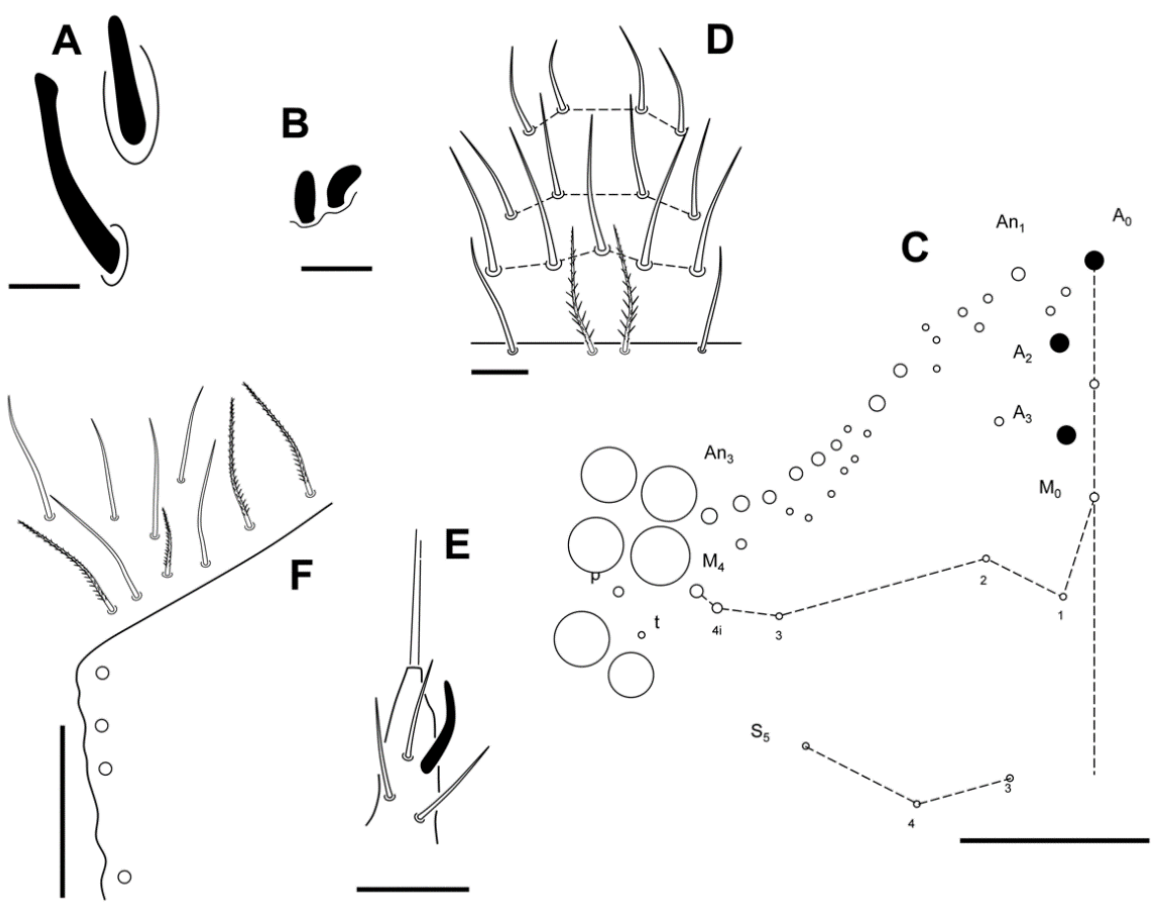
Figure 8. Pseudosinella impariciliata Baquero and Jordana sp. nov.: ( A ) AbdIV subapical organite, and accessory chaetae; ( B ) rod-shaped sensilla of the AntIII sensory organ; ( C ) dorsal head chaetotaxy; ( D ) prelabral and labral chaetae; ( E ) labial papilla E; ( F ) post-labial chaetae (scale bars: ( A , B ) 0.001mm; ( C , F ) 0.05mm; ( D , E ) 0.01 mm).